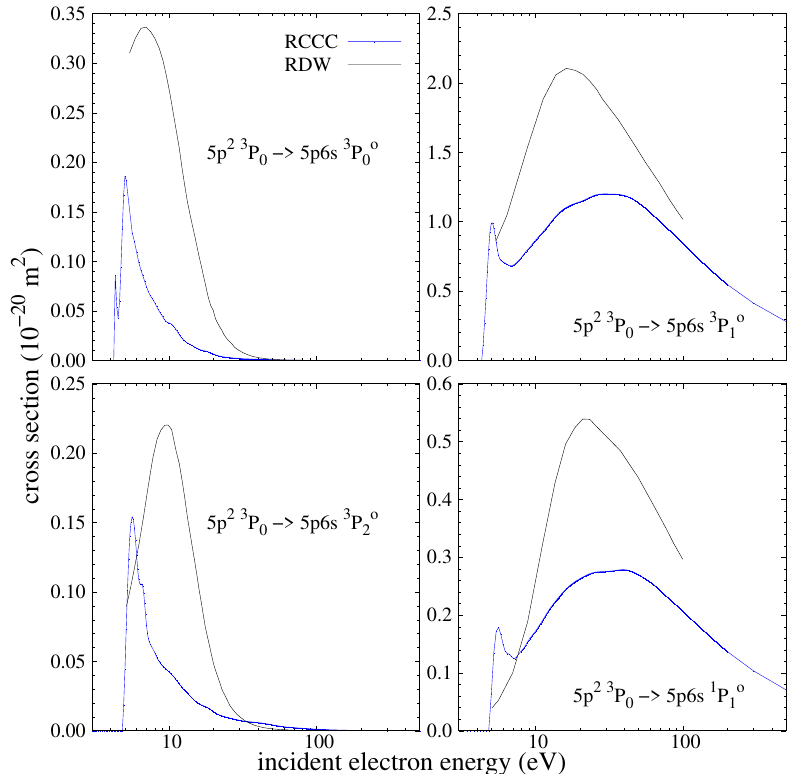
Figure 10. RCCC-integrated cross sections for excitations to the 5 p 6 s manifold from the ground state. Comparison with the RDW results by Sharma et al. [8] is